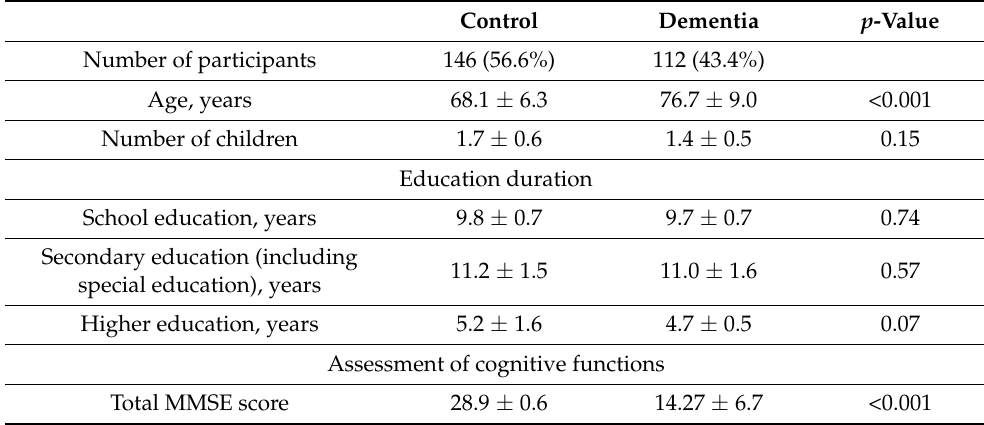
Table 2. Socio-demographic and clinical characteristics of healthy volunteers and dementia patients.